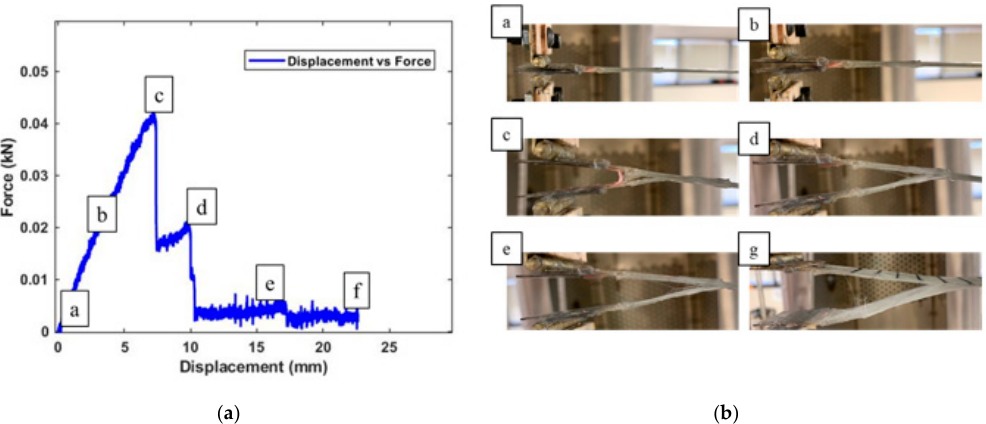
Figure 18. SWCNT/Terfenol-D composite: ( a ) delamination location on the displacement response Figure 18. SWCNT / Terfenol-D composite: ( a ) delamination location on the displacement response